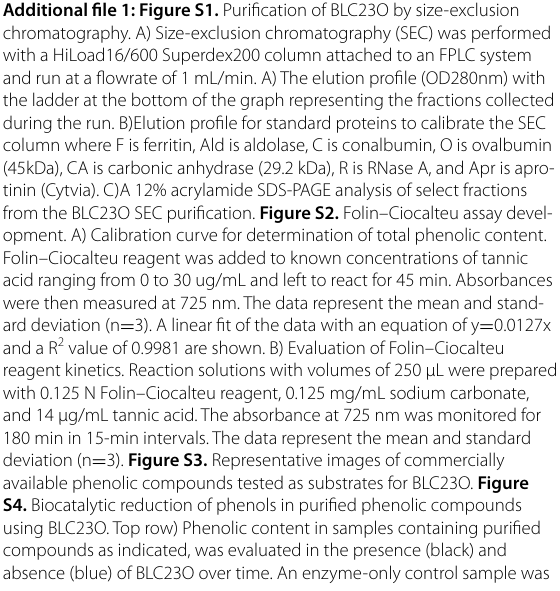
Statistical analysis and graphing